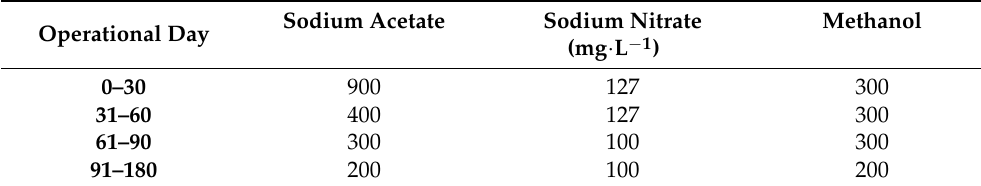
Table 1. Carbon (sodium acetate and methanol) and nitrate concentrations added to the syn- thetic groundwater used to feed aerobic granular pilot plants inoculated with denitrifying Pseu- domonas